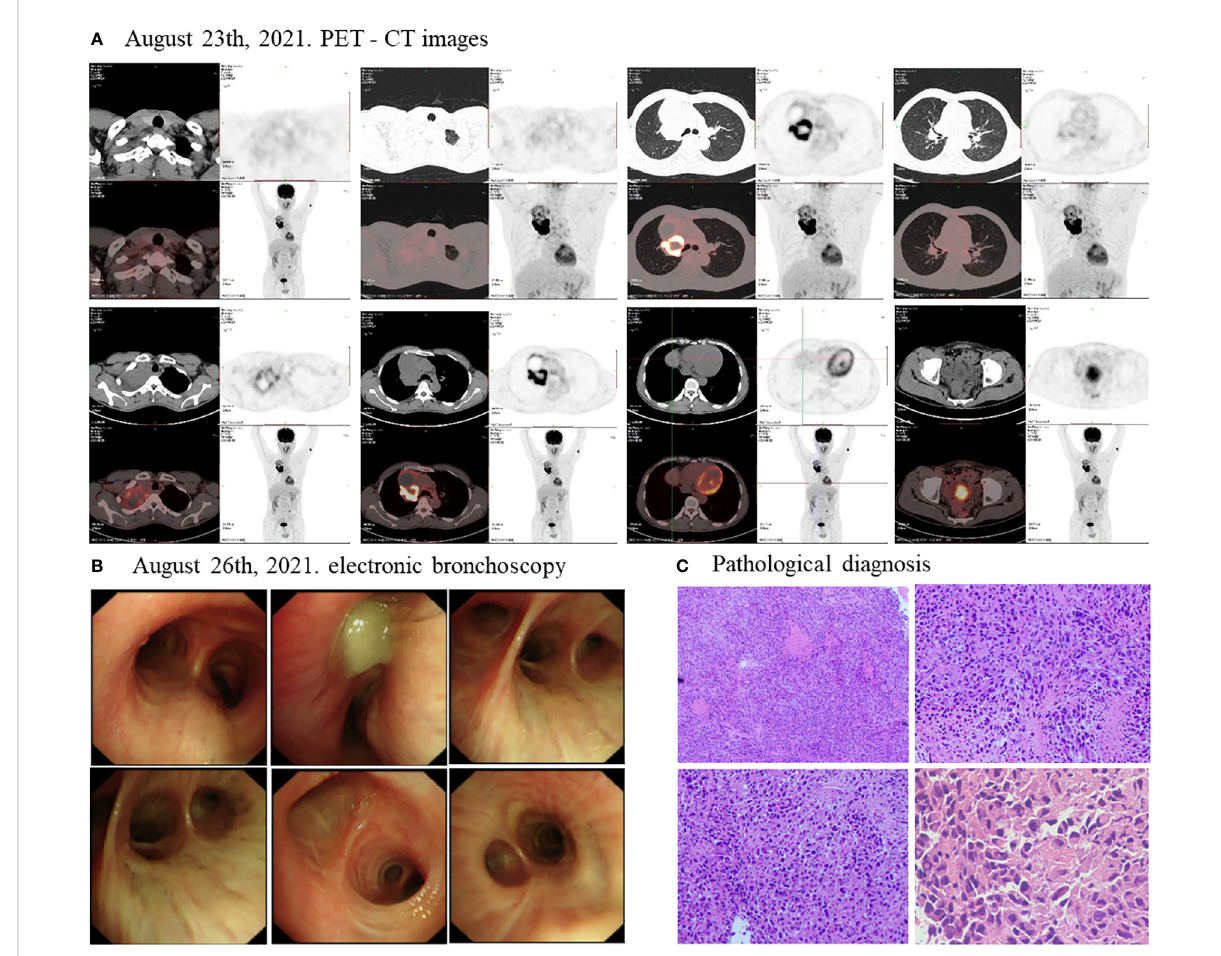
FIGURE 1 Disease status before treatment. The PET-CT scan (A) showed that before treatment, the size of the lung fi eld from the right hilum to the right upper lobe of the lung large cystic solid mass was 8.6 × 5.9 × 9.9 cm. (B) The electronic bronchoscopy of the patient before treatment. (C) Pathological diagnosis of the patient before